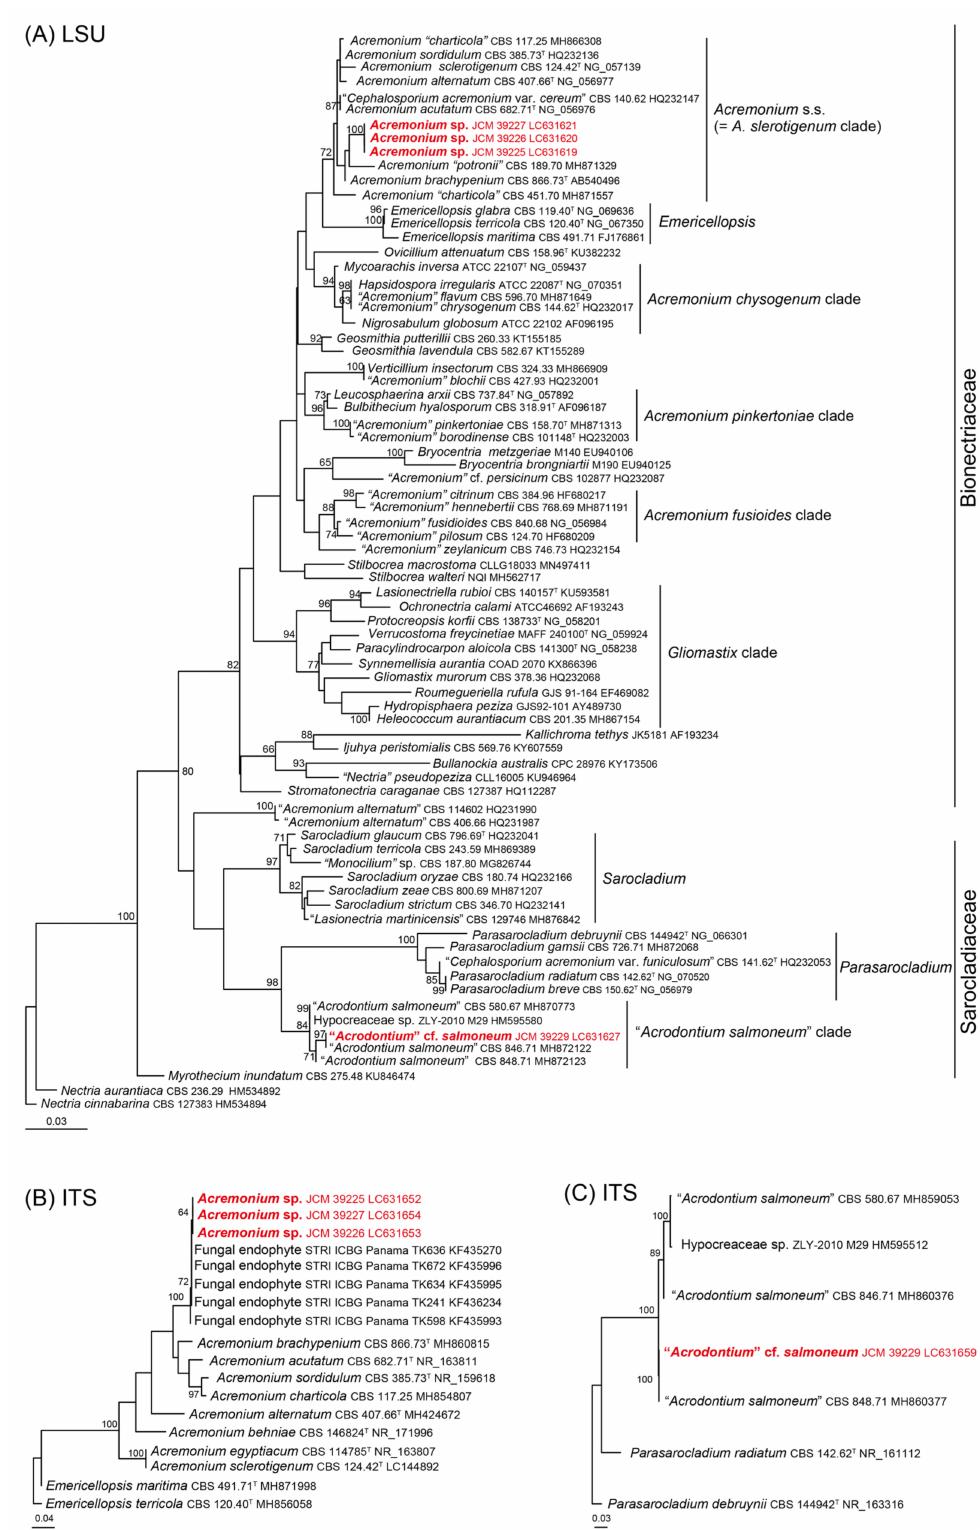
Figure 6. Maximum-likelihood (ML) tree of Bionectriaceae and Sarocladiaceae. ( A ) Species relationship of Bionectriaceae and Sarocladiaceae by TIM3e+I+G4 model based on the LSU sequences. ( B ) Species relationship of Acremonium spp. by TIM2e+G4 model based on the ITS sequences. ( C ) Comparison of environmental samples with “ Acrodontium ” salmoneum complex by TNe model based on the ITS sequences. Standard nonparametric bootstrap greater than or equal to 60% are presented at the nodes. Ex-type strains are indicated with a superscript T. The sequences in this study are shown in bold. The scale bar represents nucleotide substitution per